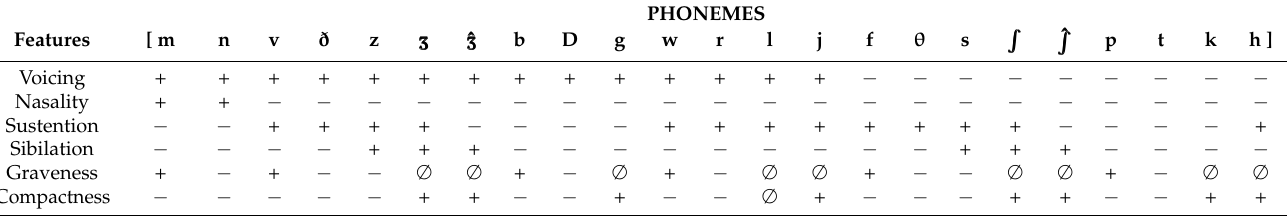
Table A1. Consonant Taxonomy used in construction of the DRT.